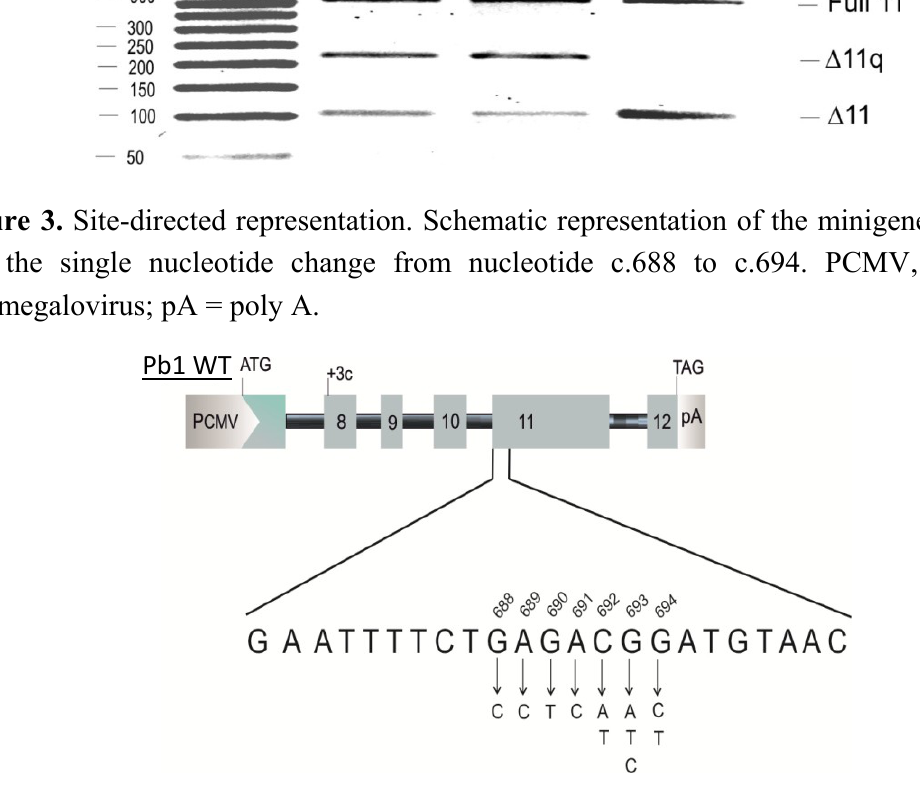
Figure 4. Minigene analysis by site-directed mutagenesis in BRCA1 exon 11. ( A ) The upper diagram shows a 1.5% agarose gel of the single point mutation. Full 11 represents the full 11 isoform, D11q the Δ11q isoform, and D11 corresponds to the Δ11 isoform; ( B ) the lower panel shows the percentage (%) of the full 11, Δ11q and Δ11 isoforms, respectively, calculated against the total expression of the three isoforms. The intensity of the each band was calculated using Image J (National Institute for Health, Bethesda, MD, USA). M—ladder. M 100